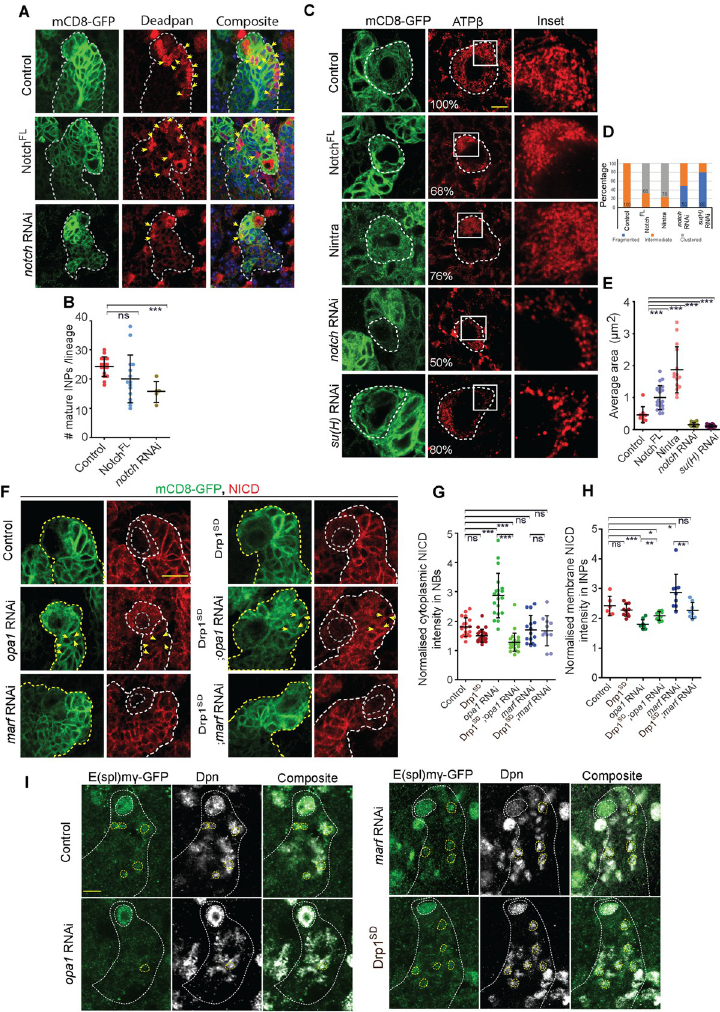
Fig 6. Analysis of mitochondrial morphology in Notch mutants and Notch signaling in Opa1 depleted type II NB lineages. A:B: Representative confocal images of type II NB lineages (A) showing reduced numbers of mature INPs in notch RNAi. Quantification of mature INPs (B) in Control (16 type II NB lineages, 4 brains), Notch FL (15,5), notch RNAi (5,3). C-E: Type II NBs (mCD8-GFP, green, yellow dotted line) showing Notch signaling mediated regulation of mitochondrial morphology (red) by ATP β antibody using STED microscopy (C). +/+ (100% tubular, 75 NBs, 22 Brains), Notch FL (68% clustered, 103,16), Nintra (76% clustered, 58,6), notch RNAi (50% fragmented, 30,14), su(H) RNAi (80% fragmented, 23,12). Graph shows the distribution of mitochondria into fragmented, intermediate and clustered in the form of a stacked histogram (D). The percentage documented on each bar in the histogram is for the group that is seen at the maximum extent. Average mitochondrial area quantification (E) in +/+ (9 Type II NBs,3 brains), Notch FL (22,5), Nintra (15,4), notch RNAi (16,4), su(h) RNAi (17,4). Scale bar- 5 μ m. F-H: Type II NBs (mCD8-GFP, green, yellow dotted line) stained for NICD (F) and observed for distribution in +/+, Drp1 SD , opa1 RNAi, Drp1 SD ; opa1 RNAi, marf RNAi, Drp1 SD ; marf RNAi. Quantification of NICD in type II NBs (G) in +/+ (19,10), opa1 RNAi (20,12), marf RNAi (15,12), Drp1 SD (22,5), Drp1 SD ; opa1 RNAi (28,6), Drp1 SD ; marf RNAi (11,5). Quantification of membrane NICD intensities in lineage (H, yellow arrows) in +/+ (6 lineages,3 brains), Drp1 SD (10,4), opa1 RNAi (9,3), marf RNAi (9,3), Drp1 SD ; opa1 RNAi (9,4), Drp1 SD ; marf RNAi (8,4). Scale bar- 10 μ m. I: Representative confocal images of type II NB lineages showing expression of E(spl)m γ -GFP (green) in type II NB (large Dpn+ dotted large circles) and mature INPs (small Dpn+ dotted small circles). B, D, F & G: Graphs show mean ± sd. Statistical analysis was done by using unpaired t-test. ns- non significant, � - p < 0.1, �� - p < 0.01, ��� - p <